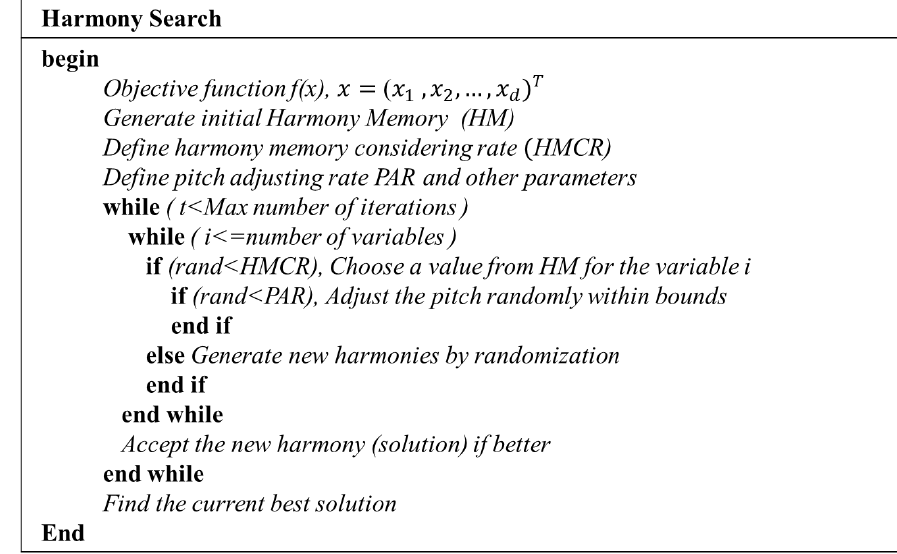
Figure 5. Pseudo-code of HS algorithm (modified from Geem [33]).